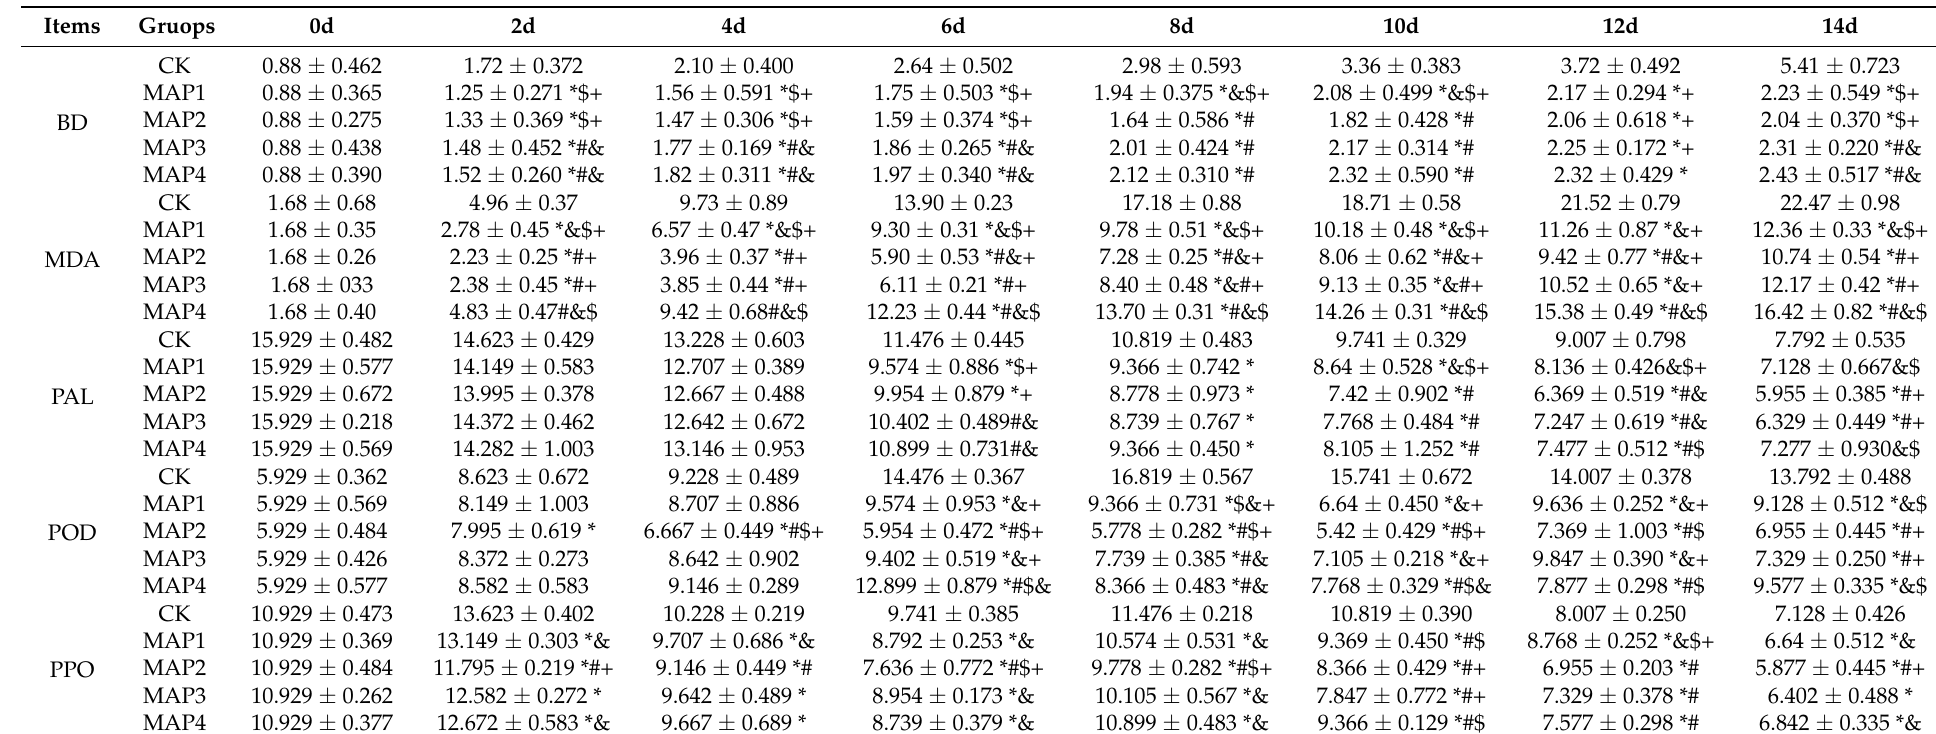
Table 2. Effects of different proportions of gas on changes in BD, MDA content, PAL activity, POD activity and PPO activity of Lanzhou lily